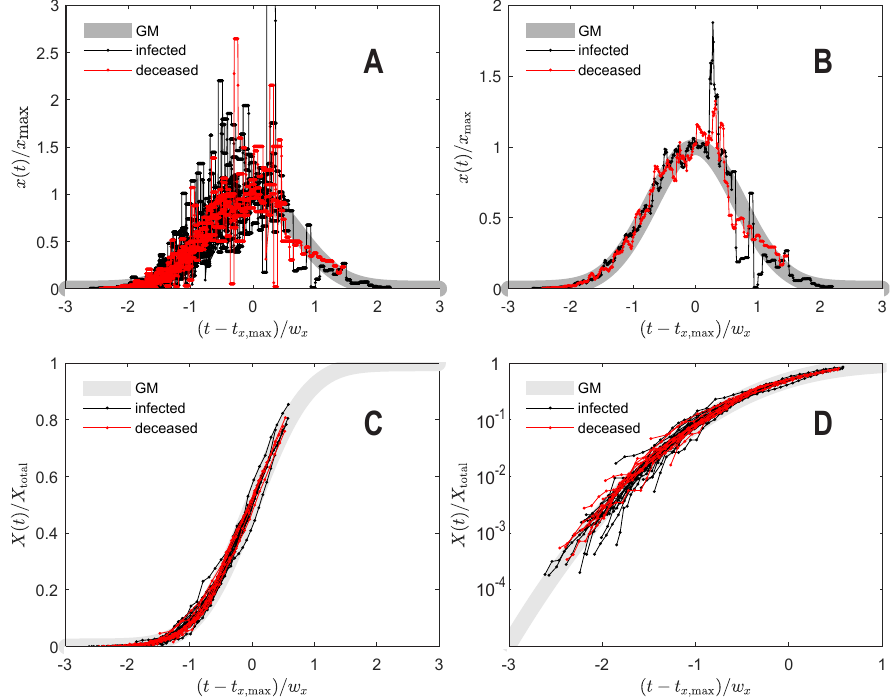
Figure 3. Shifted and rescaled data separately for each of the 25 countries. ( A ) Number of daily infections and fatalities. ( B ) Obtained from data shown in ( A ) by averaging over entries at the same ( t − t ) / w d ,max d (bin size 0.01). ( C ) Number of cumulative infections and fatalities over time in normal scale, and ( D ) in logarithmic scale to appreciate different regimes with better resolution. Thick gray is the theory expression in Equation (A1) for daily, and Equation (A7) for cumulative casualties in ( A – D ). Data beyond ( t − t d ,max ) / w d = 0.6 are from China alone. Raw data taken from Ref.